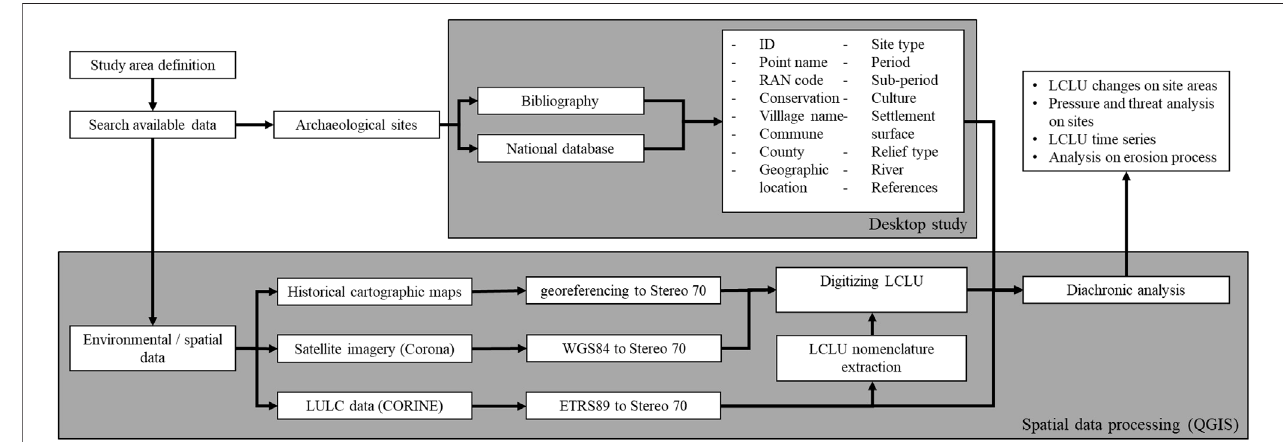
FIGURE 3 | Schematic representation of the methodology used in the present study.